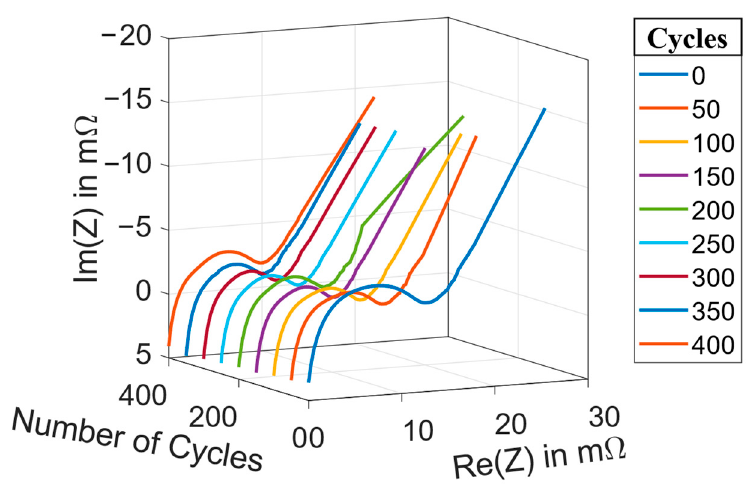
Figure 6. Impedance spectrum measurements for cell one as a function of the number of cycles.